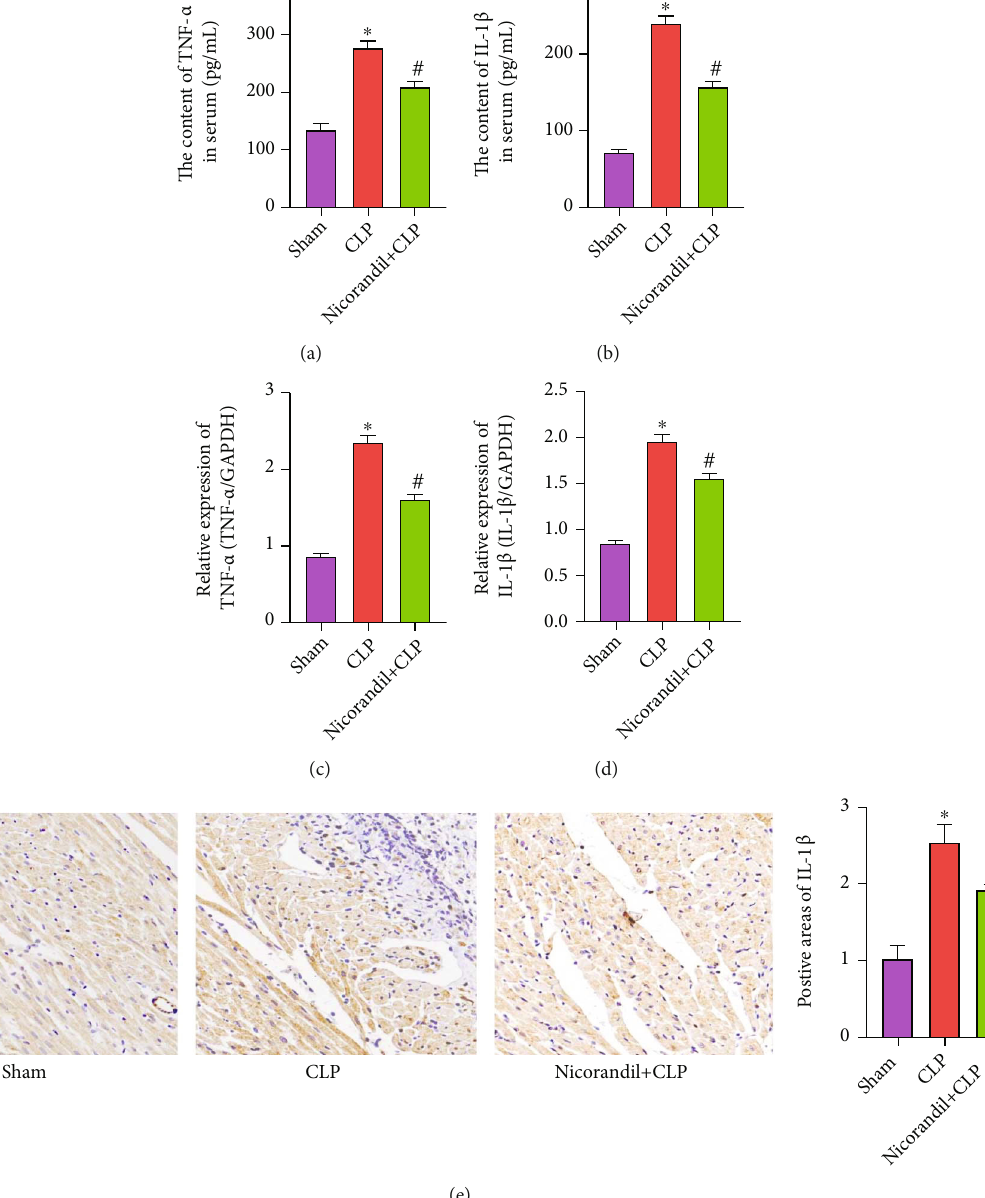
Figure 2: Nicorandil inhibits in fl ammation in rats with septic cardiomyopathy. (a) The levels of TNF- α in serum of three groups of rats. (b) The levels of IL-1 β in serum of three groups of rats. (c) The mRNA levels of TNF- α in myocardial tissue of three groups of rats. (d) The mRNA levels of IL-1 β in myocardial tissue of three groups of rats. (e) The expression of IL-1 β in myocardial tissue was detected by immunohistochemical staining and semiquantitative analysis. “ ∗ ” P < 0 : 05 vs. sham group; “ # ” P < 0 : 05 vs. CLP